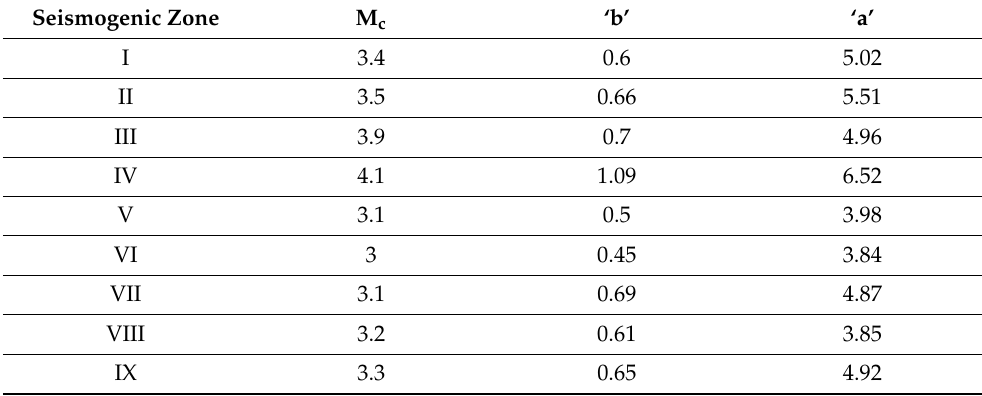
Table 6. Estimated ‘M c ’, ‘b,’ and ‘a’ values for various seismogenic zones. Seismogenic